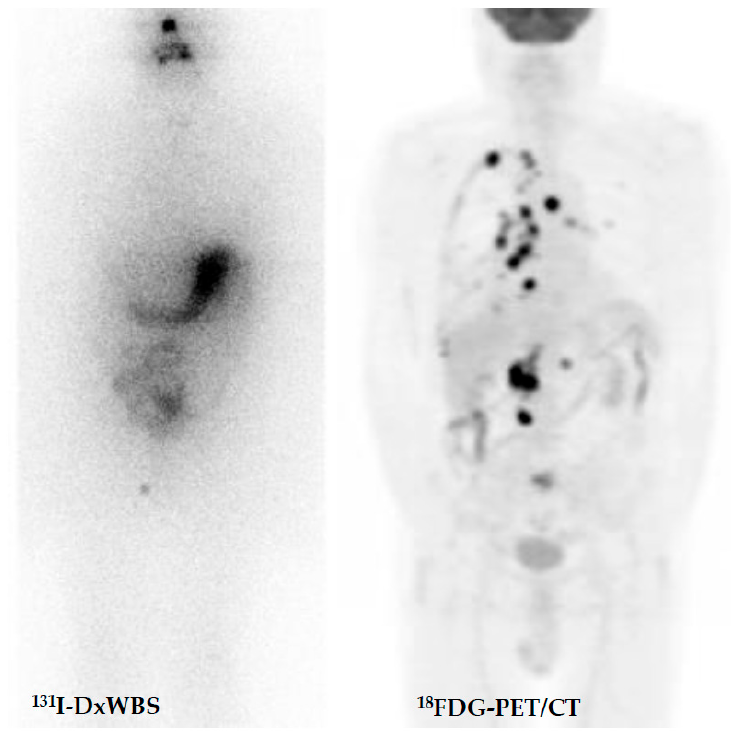
Figure 4. DTC patient with increasing thyroglobulin and negative diagnostic whole ‐ body scan after thyroidectomy and radioiodine therapy. [ 18 F]FDG ‐ avid relapsing